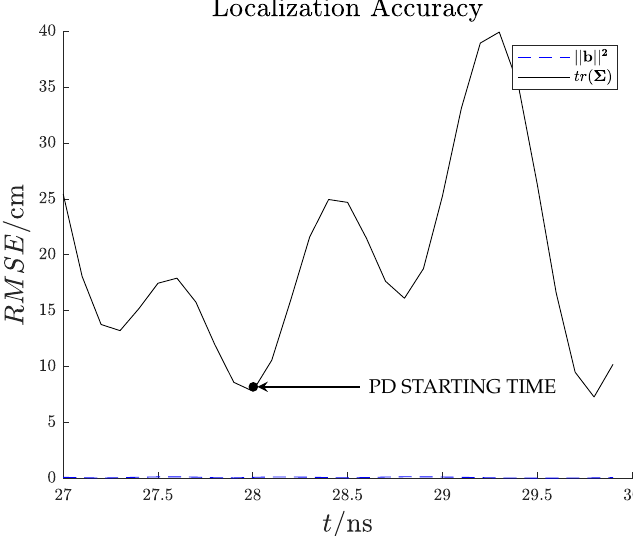
Figure 15. Test case 1. Estimated localization accuracy.